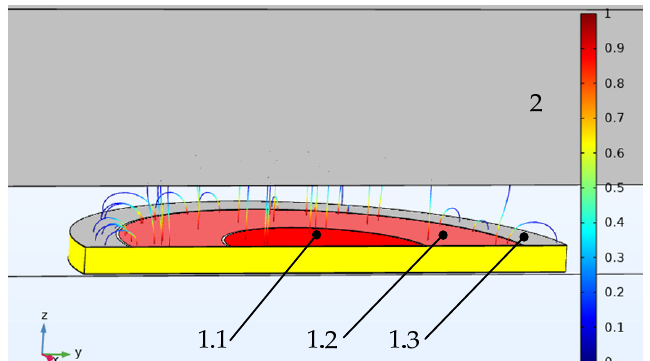
7 of 19 Figure 5. Rotating shaft vibration capacitive type 1 sensors with concentric electrodes: 1.1—potential electrode, 1.2—ground, 2—shaft. The shaft radius (shown in Figure 5 as element 2) is much larger than the radius of